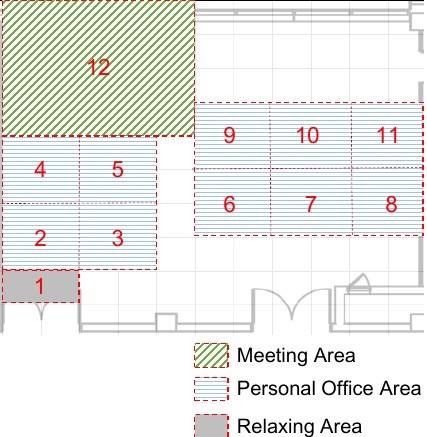
Figure 8. Classification of the space according to the characteristics.